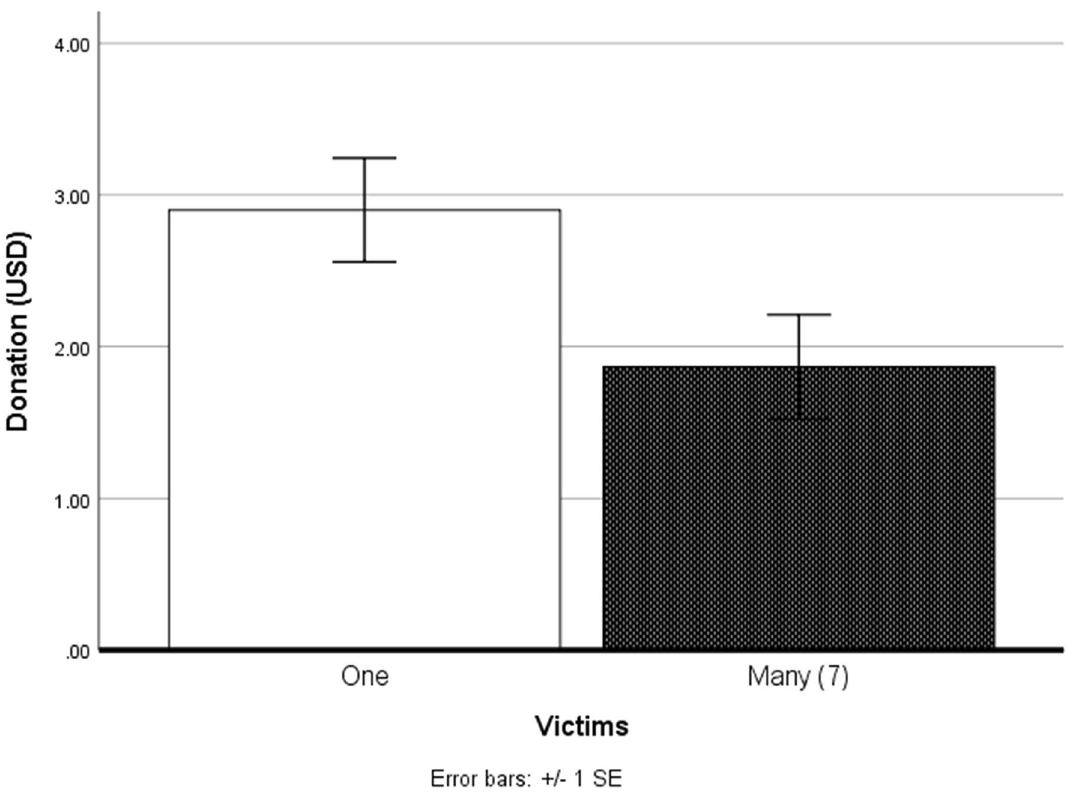
Figure 2. Compassion fade effects observed in Study 1. Participants exposed to a single non-human victim in VR (left) donated significantly more towards sea turtle conservation than those who were exposed to seven victims